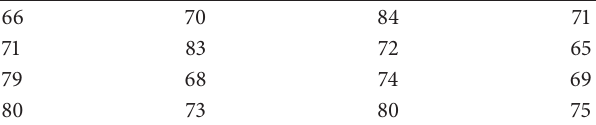
Table 1: A 4 × 4 block in a medical image.